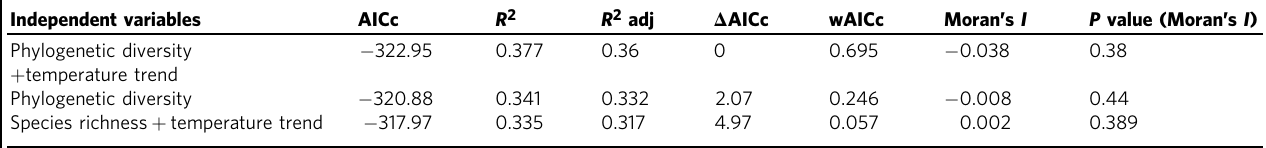
Table 2 Results of the multimodel inference at the grid cell scale for co1 .